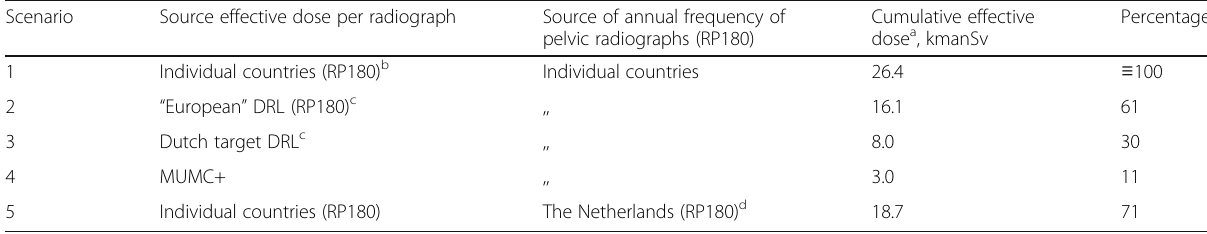
Table 4 Cumulative effective dose caused by AP pelvic radiography in 35 European countries